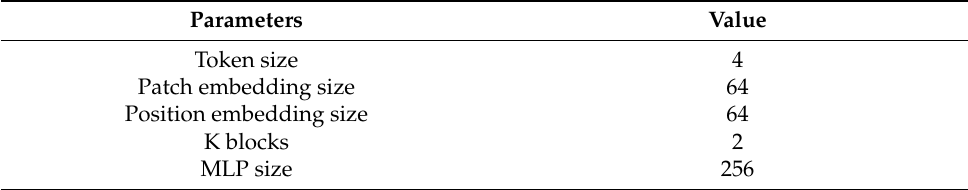
Table 1. Parameters of signal transformer.